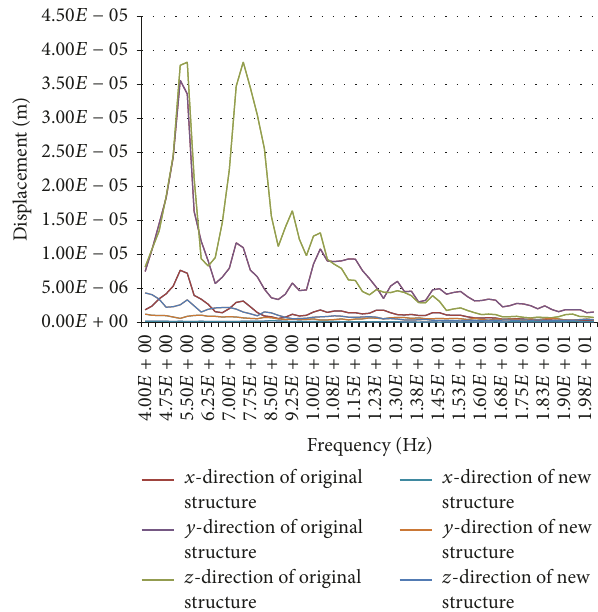
Figure 22: The FFT spectrums of original and new structure at Location